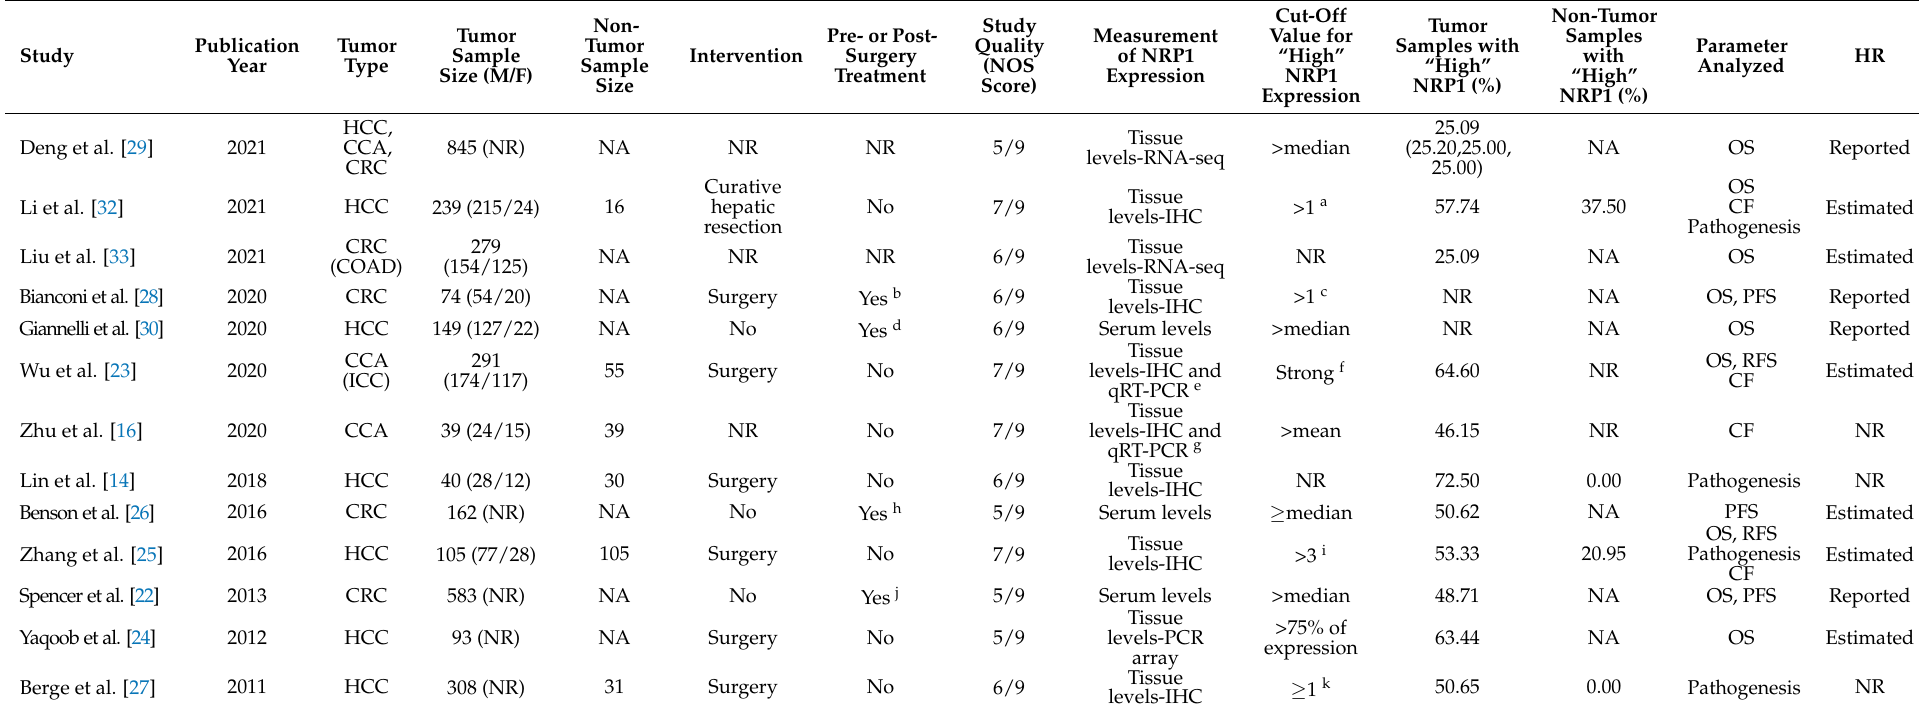
Table 1. Baseline characteristics of included